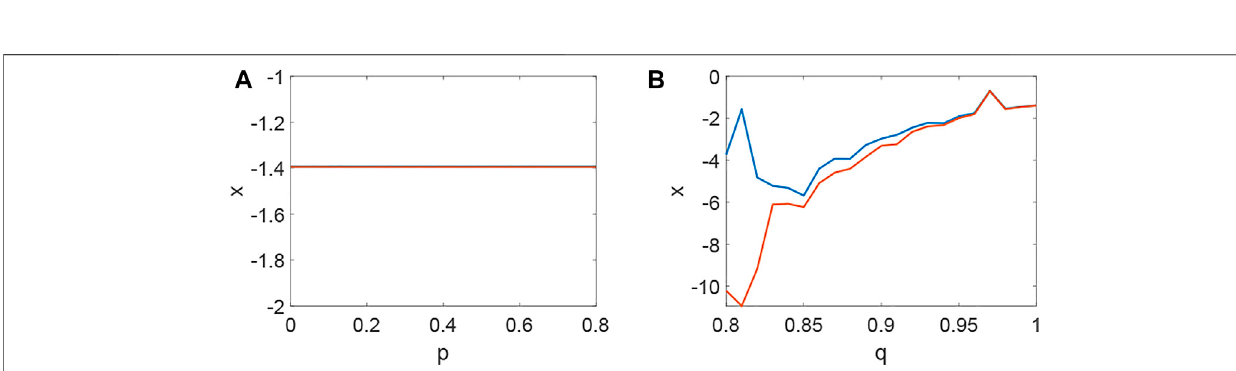
FIGURE 7 | The bifurcation about p , q when τ = 0. (A) The inexistence bifurcation about p when q = 0. (B) The bifurcation about q when p = 0.1.